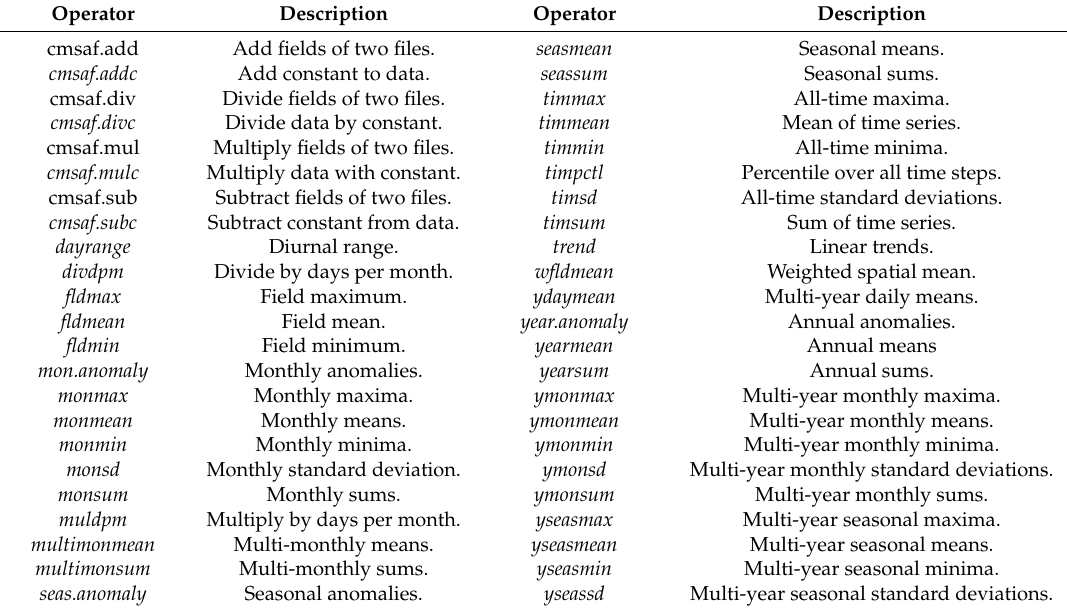
Table 1. Operators for data analysis of the cmsaf R-package (version 1.9.5). Operators that are included in the CM SAF R Toolbox are marked in italics.